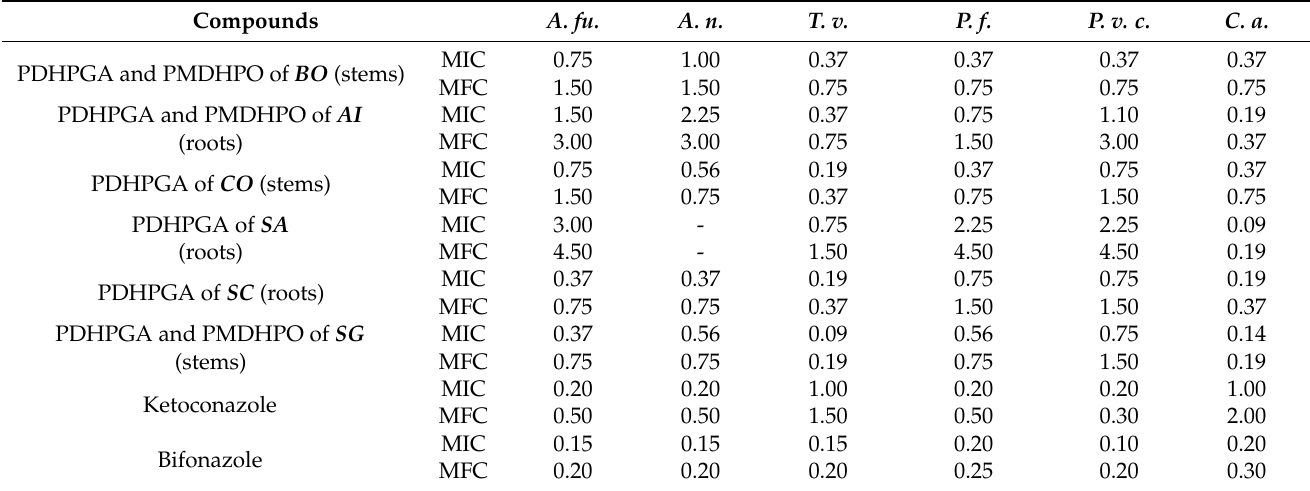
Table 3. In vitro antifungal evaluation of PDHPGA and PMDHPO from stems and roots of BO, AI , CO , SA , SC , and SG